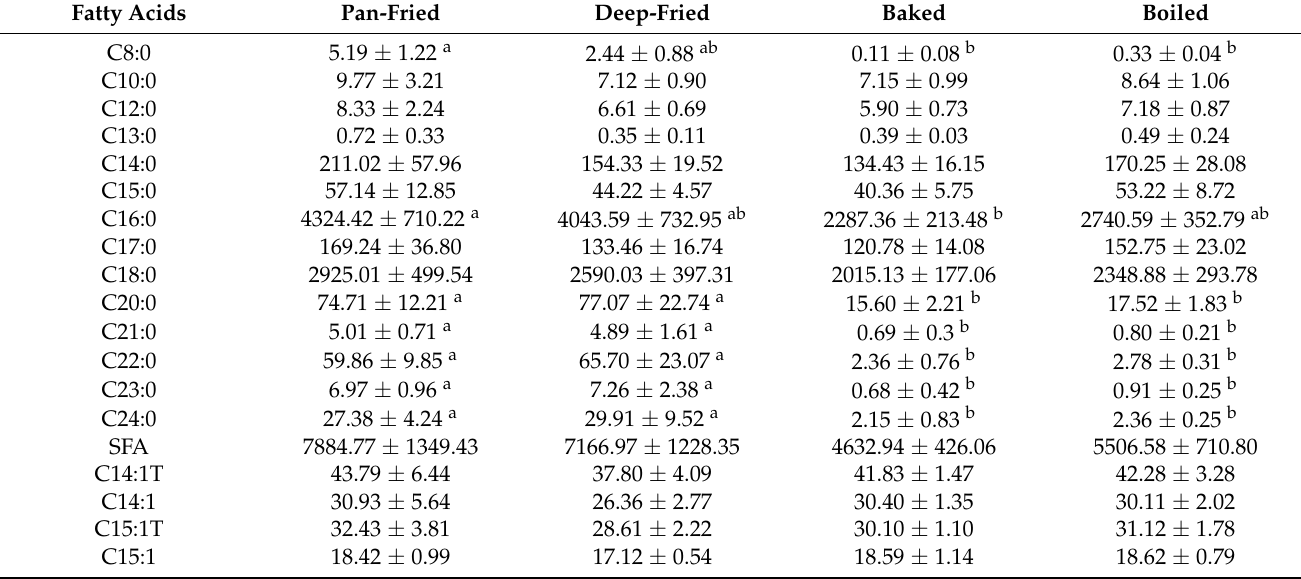
Figure 3. Fatty acid composition of BTS meat after different thermal processing; PUFA: polyunsatu- rated fatty acids; MUFA: monounsaturated fatty acids; SFA: saturated fatty acids. Table 5. Fatty acids of BTS meat under different processing methods ug/g